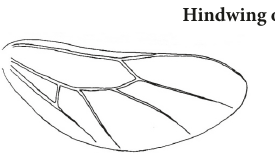
Figure 5: Hindwing of genus Titanomyrma